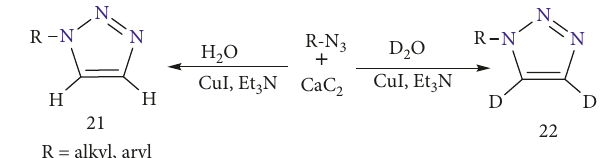
Scheme 11: Synthesis of 1,2,3-triazoles from Alkyl or Aryl